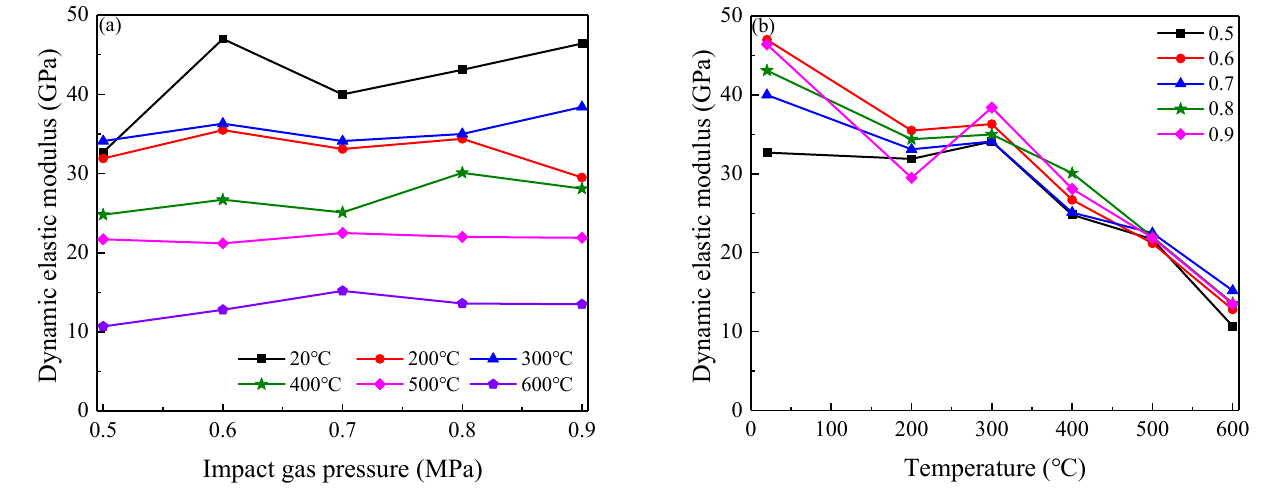
Figure 11. Dynamic elastic modulus of specimens. ( a ) Impact gas pressure, ( b ) Temperature.